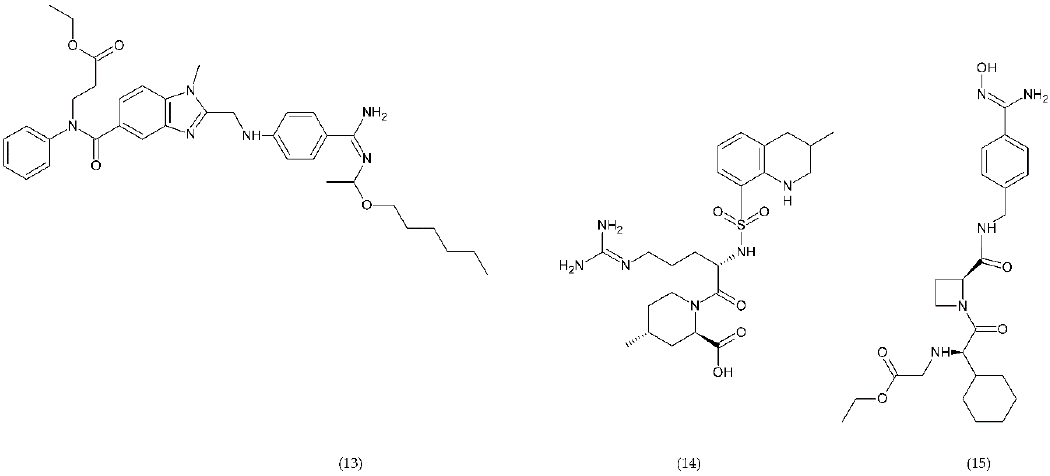
Figure 8. Direct monovalent thrombin inhibitors: dabigatran (13), argatroban (14), ximelagatran (15).